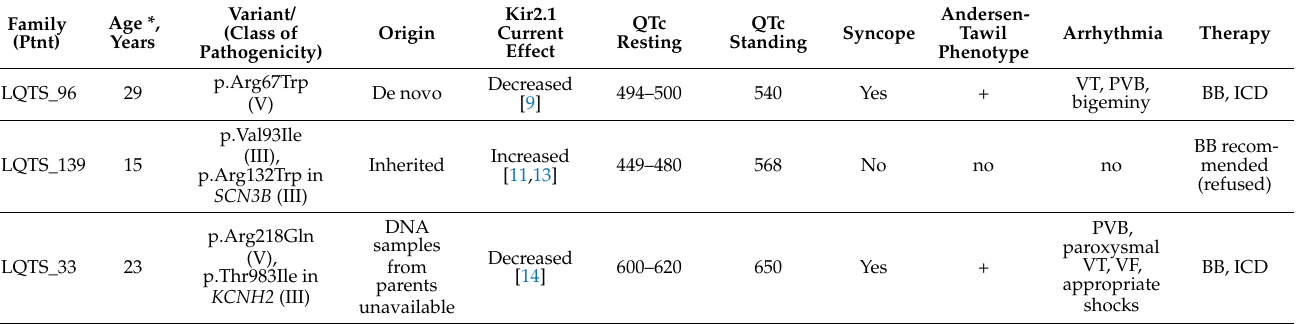
Table 1. Clinical and genetic characteristics of the probands with rare heterozygous variants in the KCNJ2